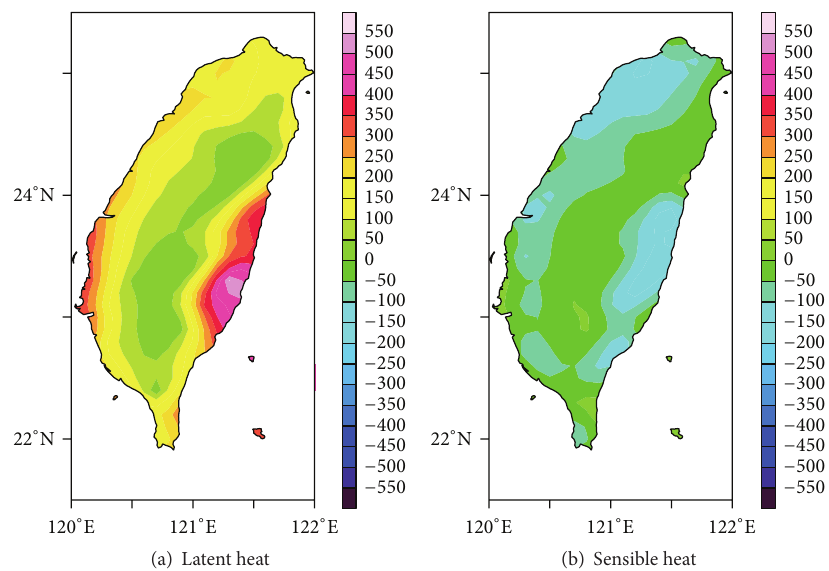
Figure 4: Simulated surface (a) LH flux (Wm −2 ) and (b) SH flux (Wm −2 ) averaged over 54h integration of Taiwan Island.